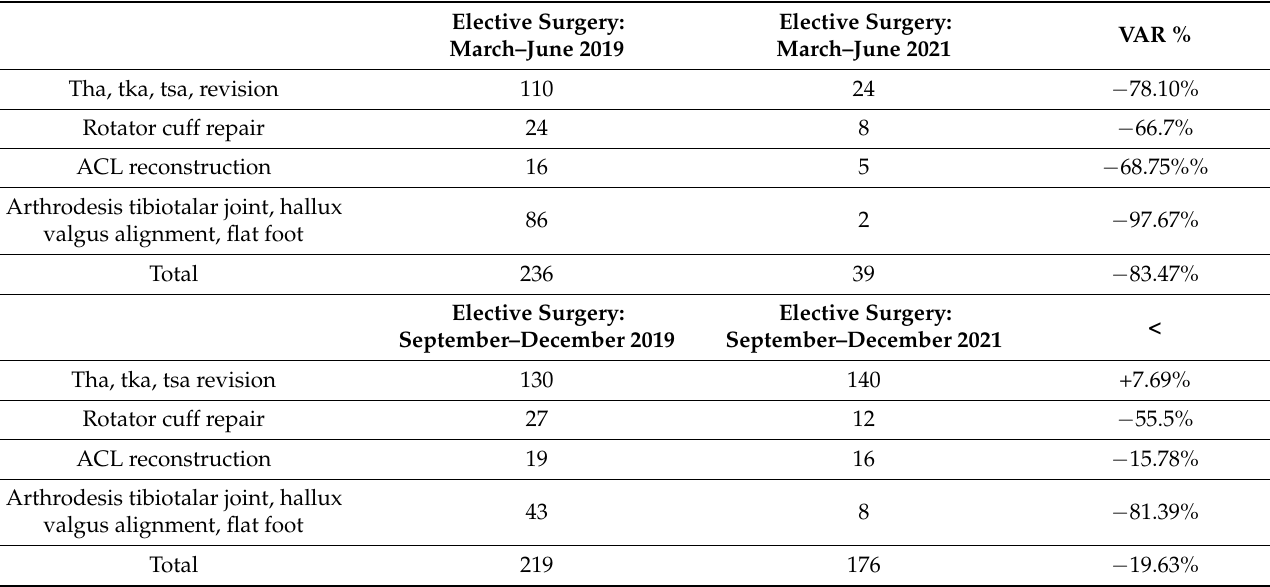
Table 1. Elective